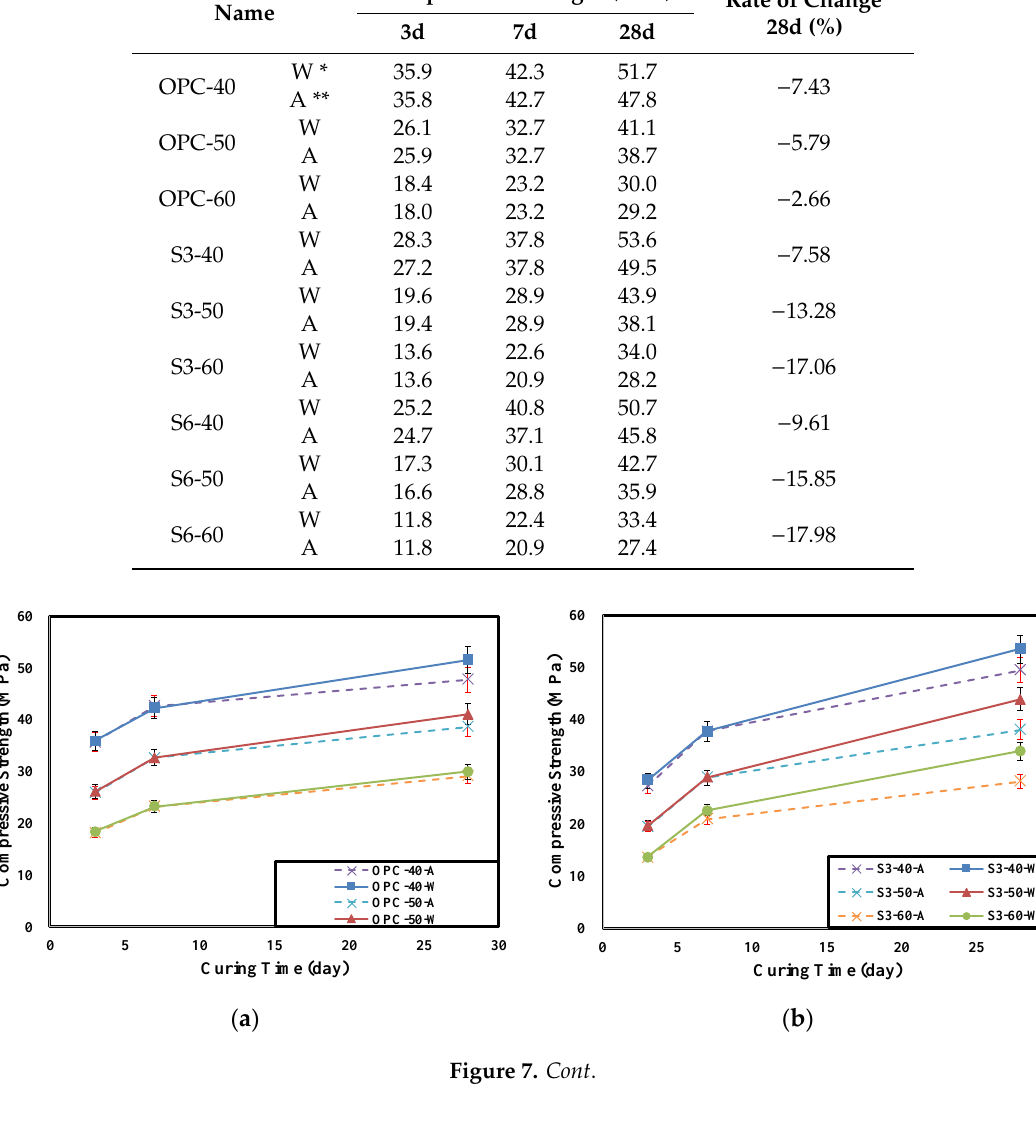
Table 5. Result of compressive strength test.